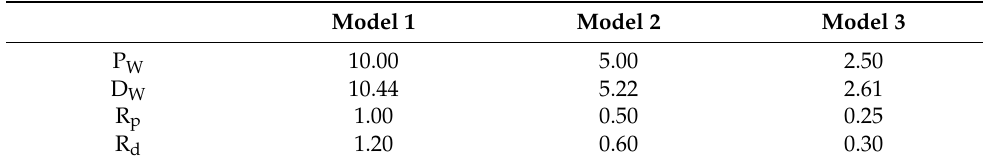
Table 2. Relevant parameters of the flange die. (unit: